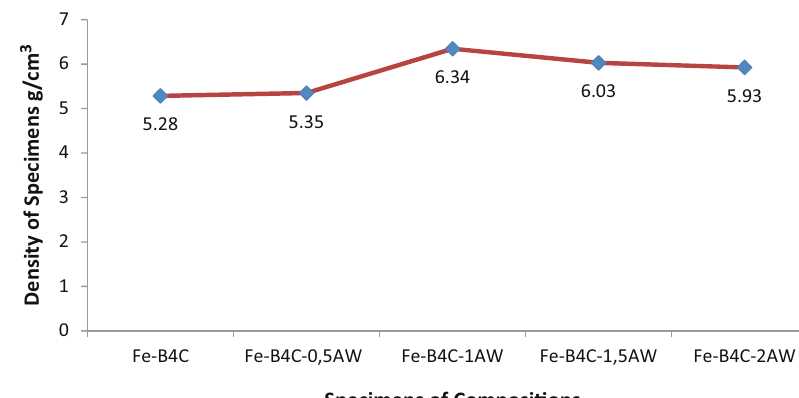
Figure 1: Composition – density change curve of ceramic – metal